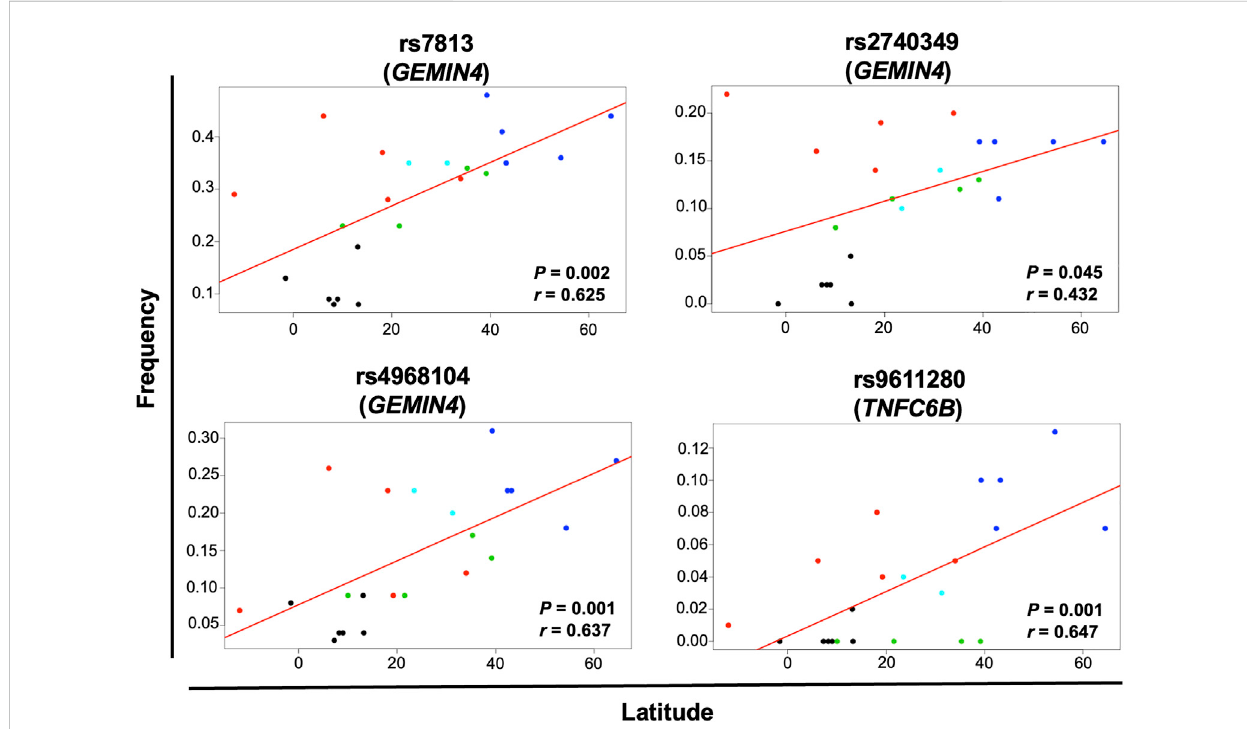
FIGURE 5 Signi fi cant correlation of the minor allele frequency of SNVs with latitude. The correlation of minor allele frequencies reported in sub-continental populations from the 1,000 Genome project and those found in this study for the MEZ population with longitude and latitude was evaluated by the Pearson ’ s correlation test. Gene variants with p < 0.05 for latitude correlation are shown in the fi gure. Black dots = African groups; red dots = Admixed Latino American groups; blue dots = European groups; green dots = East Asian groups; turquoise dots = South Asian